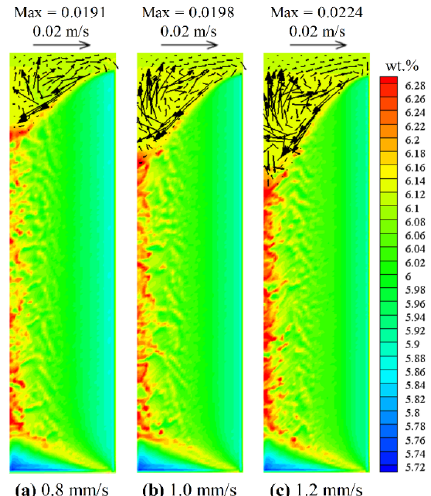
Figure 9. Macrosegregation maps predicted in the non-grain-refined billet with different casting speeds of ( a ) 0.8 mm/s (case 3), ( b ) 1.0 mm/s (case 2), and ( c ) 1.2 mm/s (case 4) when the maximum height is reached.